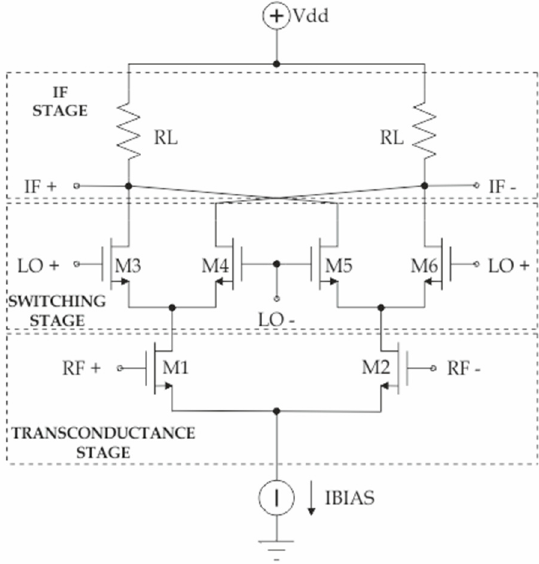
Figure 1. Double-balanced Gilbert cell mixer.